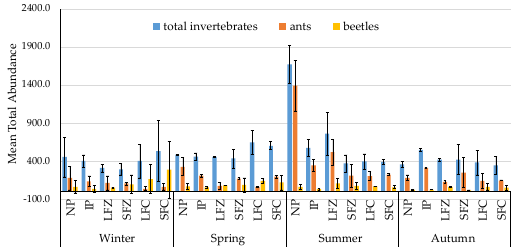
Figure 2. Seasonal variations in mean total abundance of invertebrates collected (total invertebrates, ants and beetles per field) during the study period under agricultural management regimes. Each data point was the total abundance of 20 pitfall traps per site, with each field (n = 24) sampled eight times. The mean for a specific treatment was based on the number of replicates for that particular grouping. Total number of sampling occasions = 192. NP = native pasture, IP = introduced pasture, LFZ = long fallow zero tillage, SFZ = short fallow zero tillage, LFC = long fallow conventional tillage, SFC = short fallow conventional tillage.